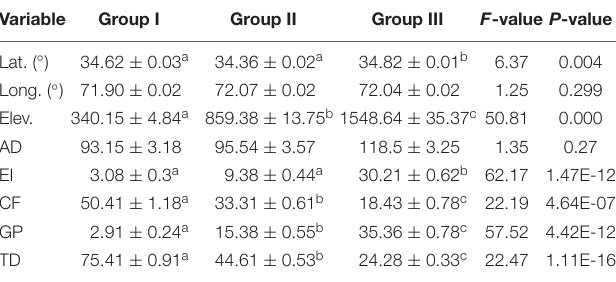
TABLE 3 | Variation of spatial parameters represented as mean and SE along the elevation gradient in